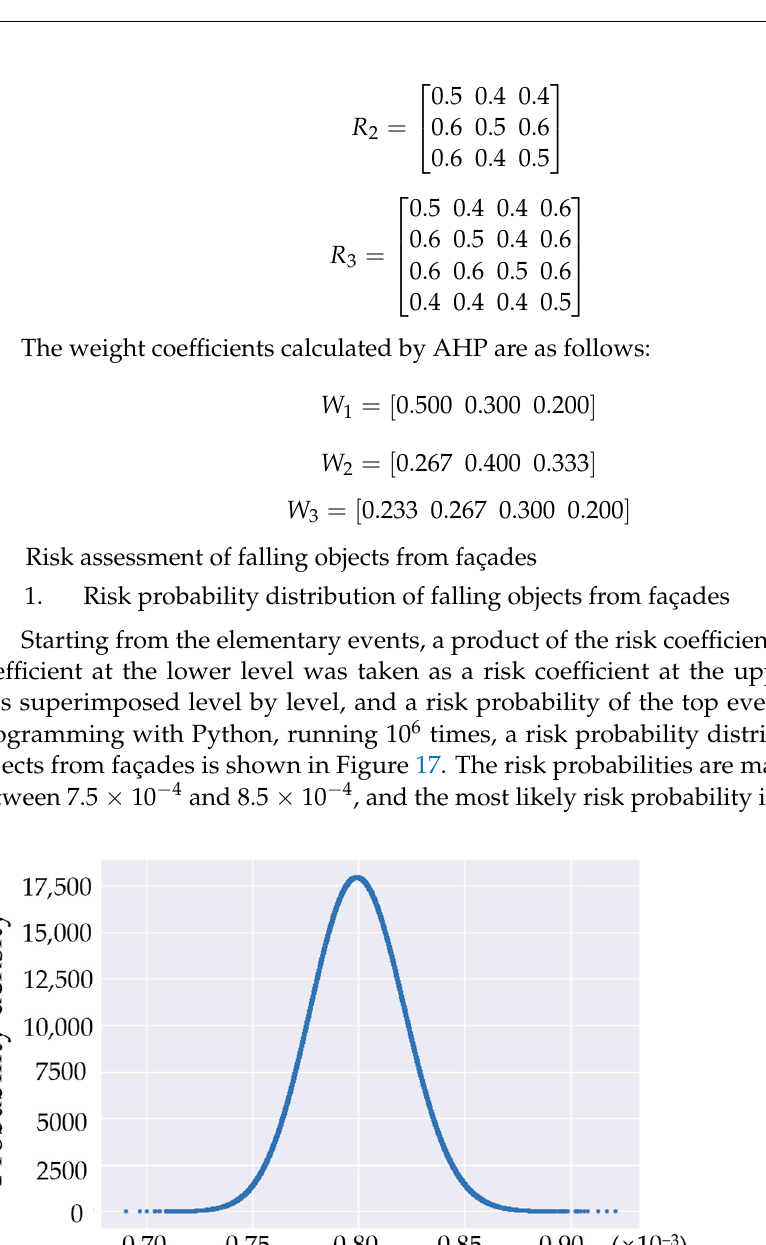
Table 4. The importance of the elementary events.